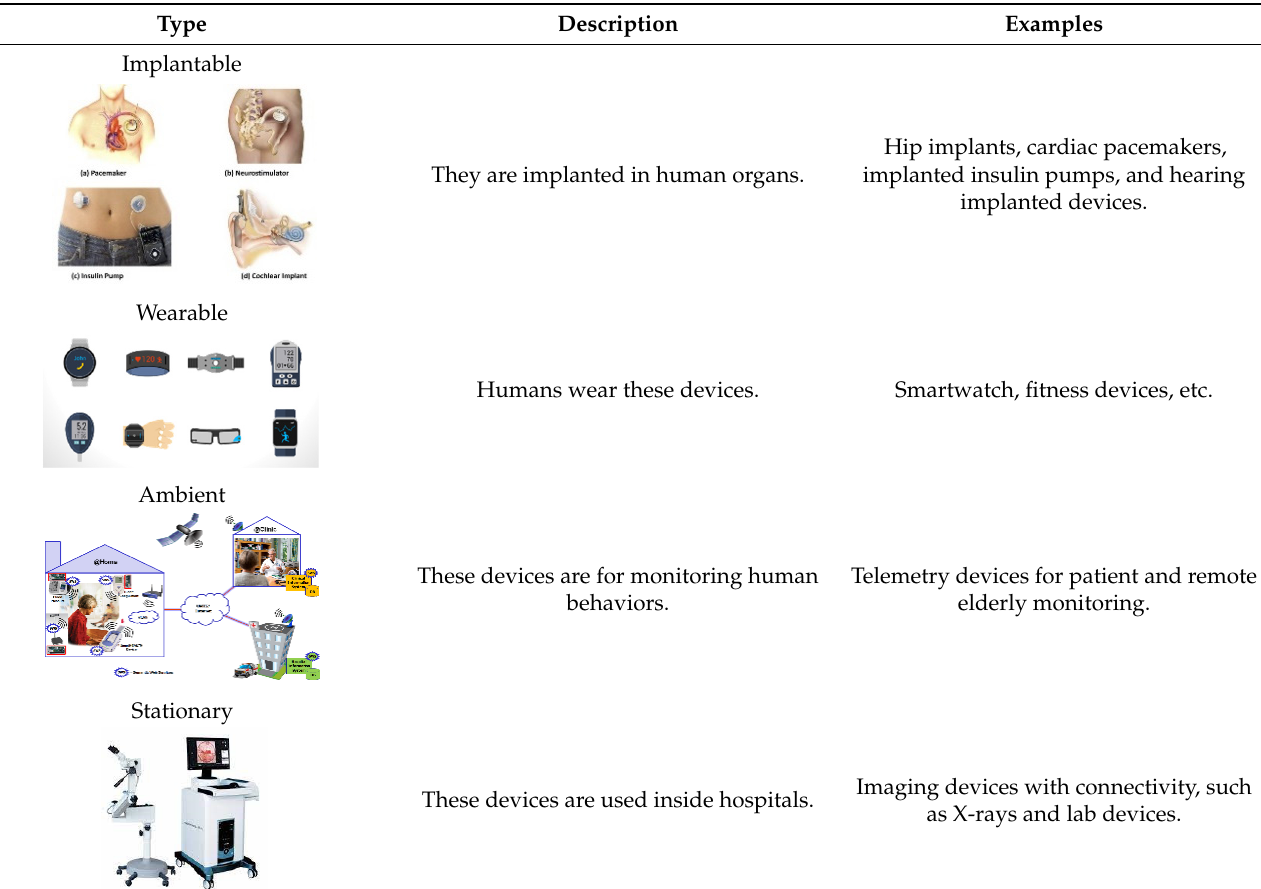
Table 1. Types of Medical IoT devices with their descriptions and examples.